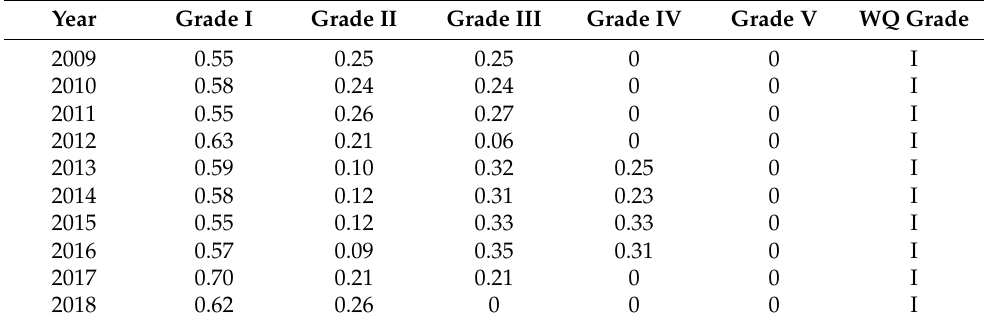
Table A11. Fuzzy integrated evaluation results of Lanshanzui Station in Yixing, Jiangsu.